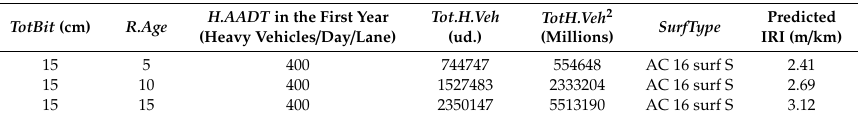
Table 14. Predicted IRI values for the section of the